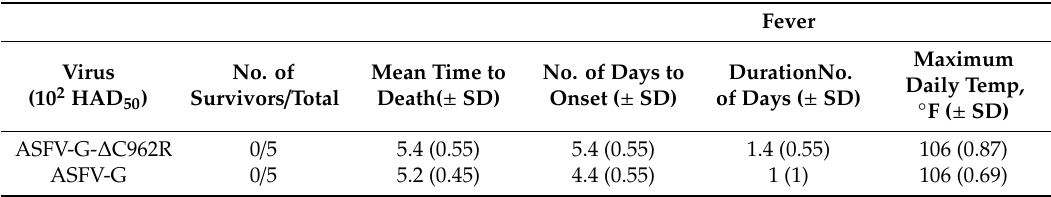
Table 1. Swine survival and fever response following infection with ASFV-G- Δ C962R and parental ASFV-G.